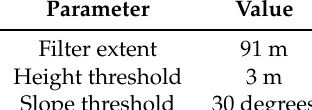
Table 13. Parameters for terrain model extraction as used in all tests.